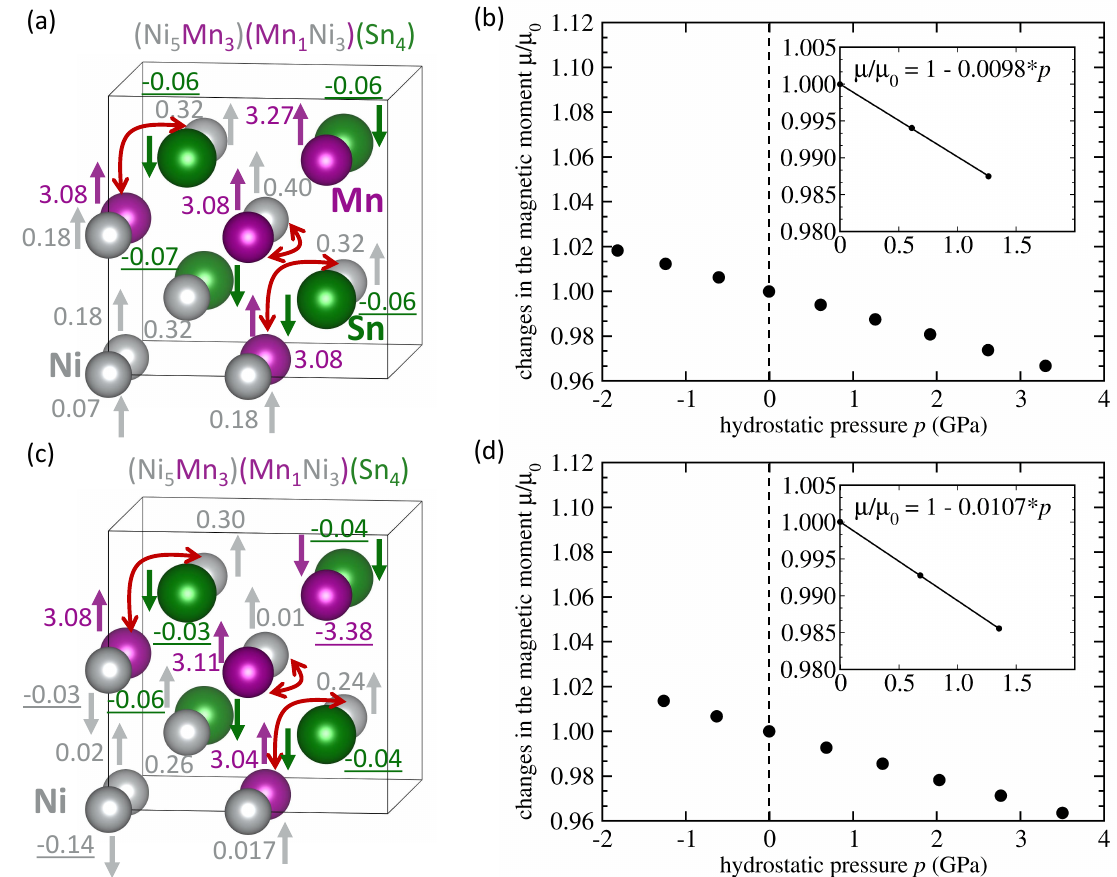
Figure 5. Similar set of figures as in Figure 4 but with three times more swapped atoms (three Mn atoms swapping with three Ni atoms, see red arrows). Schematic visualizations including local magnetic moments are shown in parts ( a , c ) for states FM and AFM coupled Mn atoms, respectively. The corresponding pressure-induced changes are presented in parts ( b , d ). Magnitudes of local magnetic moments are listed in Bohr magnetons and negative values indicate antiparallel